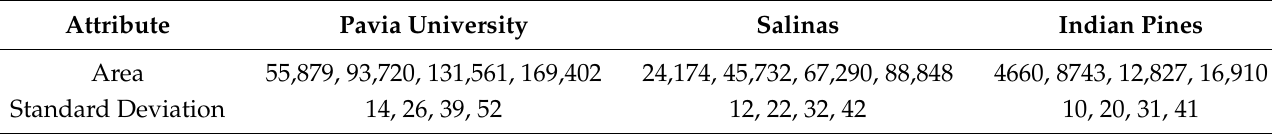
Table 1. Attribute and thresholds.